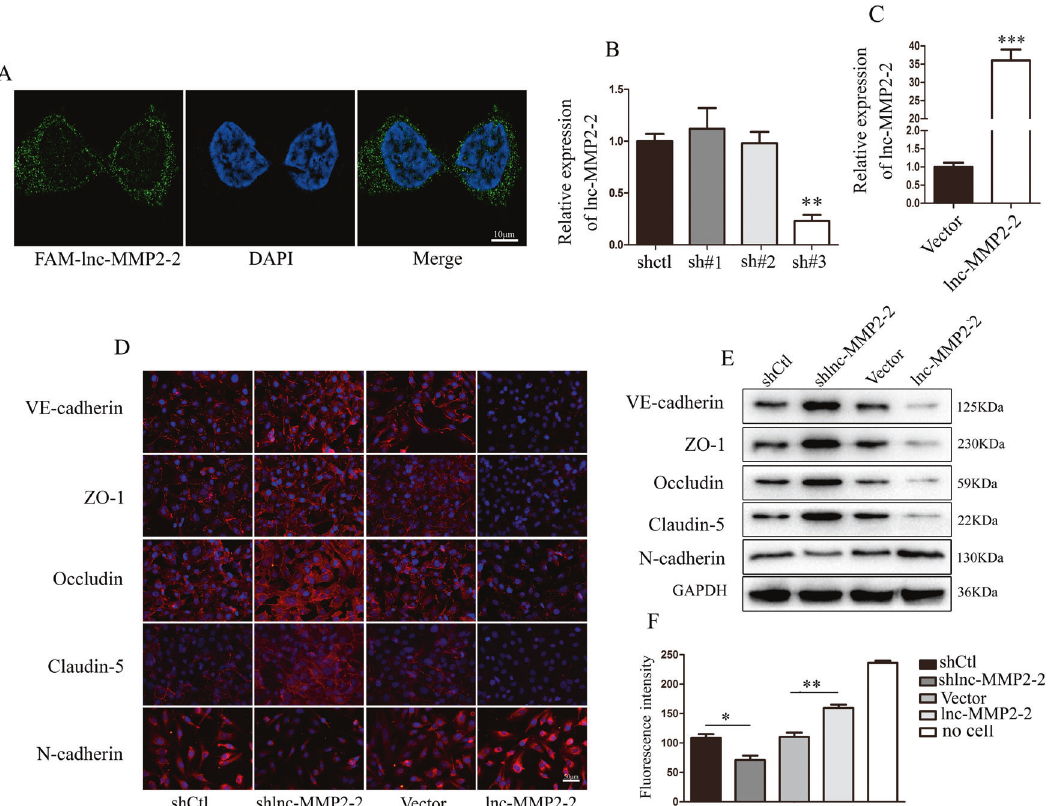
Fig. 3 lnc-MMP2-2 promotes EndoMT, destroys tight junctions, and induces HBMECs monolayer permeability in vitro. A FISH analysis of lnc-MMP2-2 location in HBMECs. B , C Infection ef fi ciency of lnc-MMP2-2 silencing and overexpression lentivirus in HBMECs detected using qRT-PCR. D , E Expression of EndoMT markers (VE-cadherin, N-cadherin) and of tight junction proteins (ZO-1, occludin, and claudin-5) in lnc- MMP2-2-silenced or -overexpressed HBMECs as measured using IF (scale bar, 50 μ m) and western blotting assays. F HBMECs monolayer permeability in stably infected cells with lnc-MMP2-2 knockdown or overexpression. * p < 0.05, ** p < 0.01, *** p <